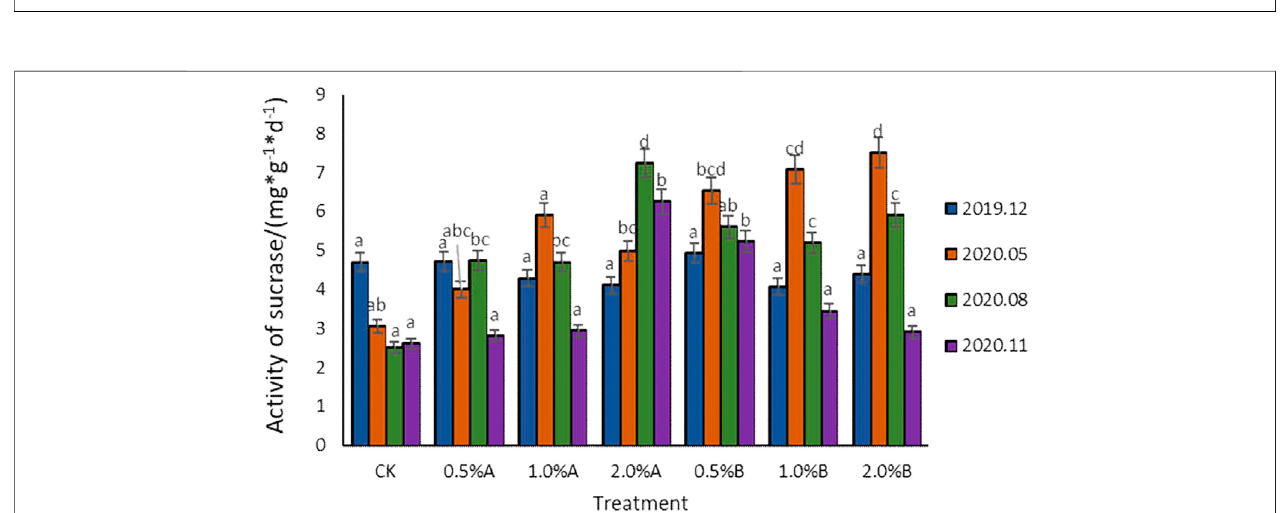
FIGURE 2 | Variation of pH with time in each treatment.